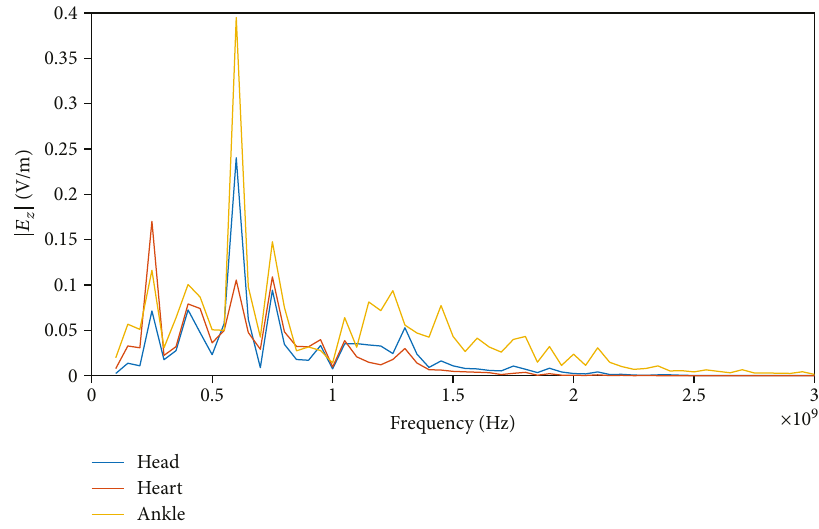
Figure 6: Electric fi eld strength at the head, the heart, and the ankle of the 3rd occupant. Table 2: Computed SAR For AT 1W